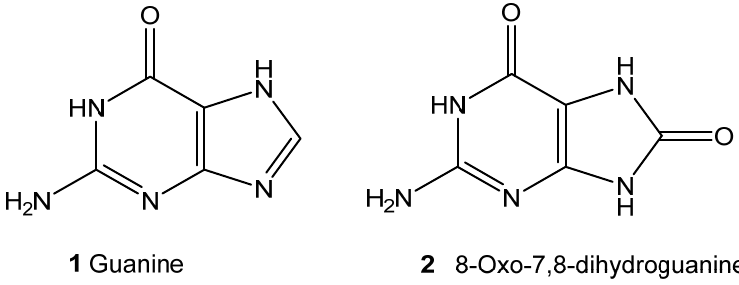
Figure 12. Guanine 1 and its oxidation product 2